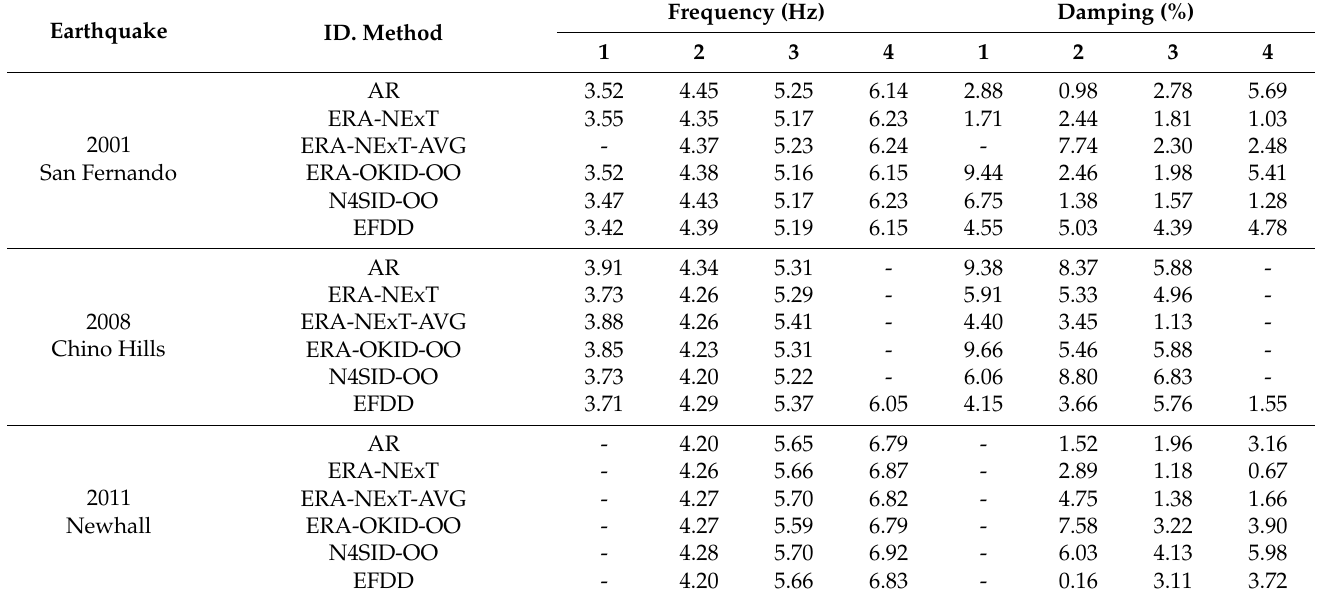
Table 4. Modal identification results of the identified frequency and damping using all seismic monitoring channel data of the dam body, dam foundation, and OO-type method.